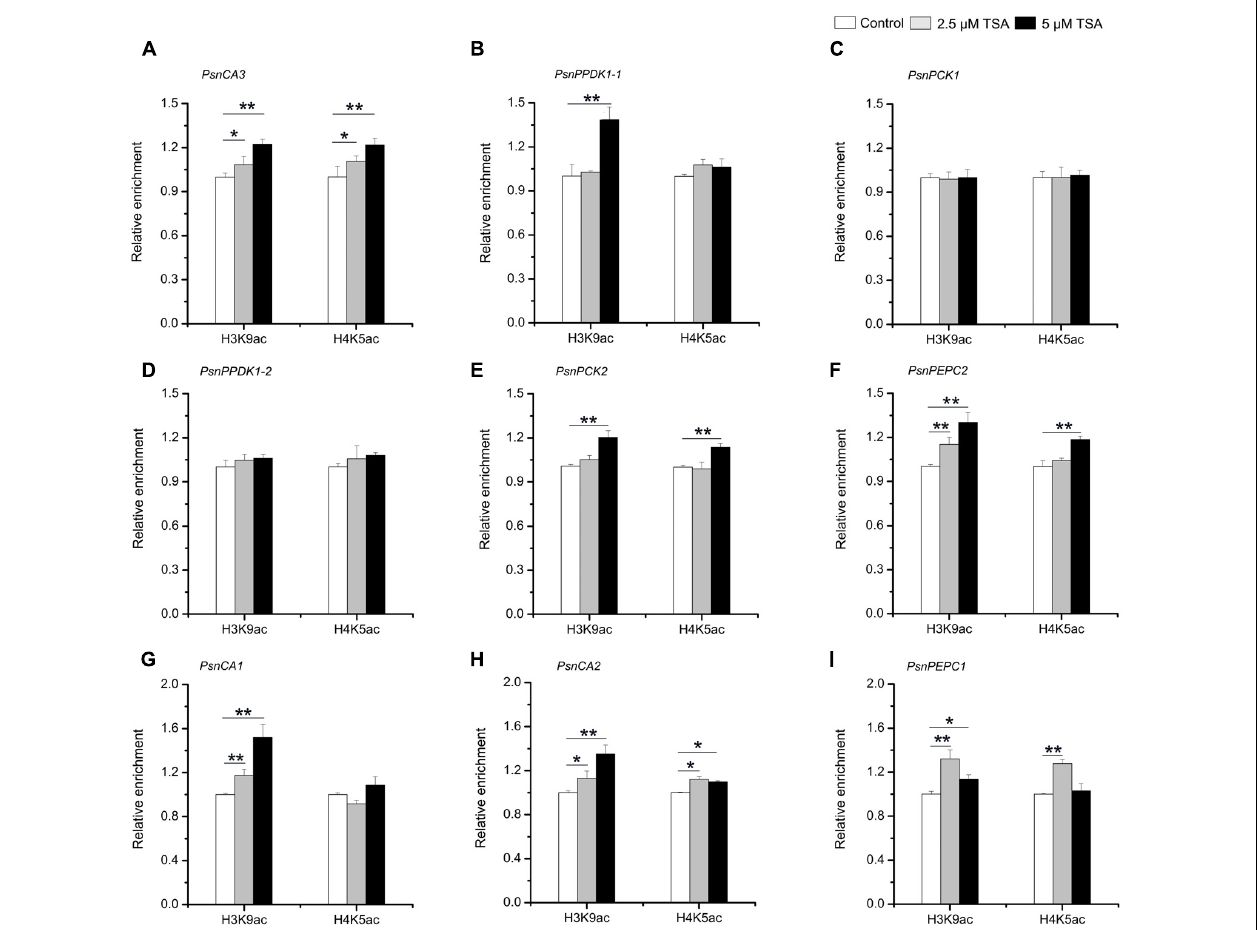
FIGURE 6 | TSA affects the level of H3K9ac and H4K5ac in the promoters of the poplar PsnCA , PsnPPDK , PsnPCK , and PsnPEPC genes. ChIP was used to detect H3K9ac and H4K5ac levels in the P3 (close to TIS) promoter region of the PsnCA3 , PsnPPDK1-1 , and PsnPCK1 genes in leaves (L) (A–C) , the PsnPPDK1-2 , PsnPCK2 , and PsnPEPC2 genes in stem chlorenchyma (Sc) (D–F) , and the PsnCA1 , PsnCA2 , and PsnPEPC1 genes in roots (R) (G–I) of poplar treated with TSA for 2 days. Levels of H3K9ac and H4K5ac were standardized by the accumulation of H3K9ac and H4K5ac in the promoter of the PsnACTIN2 gene (Supplemental Figure S4). Values are the means from three independent experiments. Bars indicate SE. Asterisks indicated significantly different means ( ∗ p < 0.05; ∗∗ p < 0.005) as determined with a t